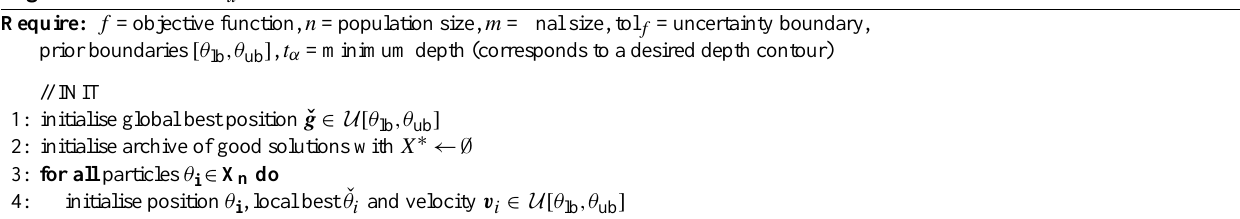
Algorithm 5 PSO-GA